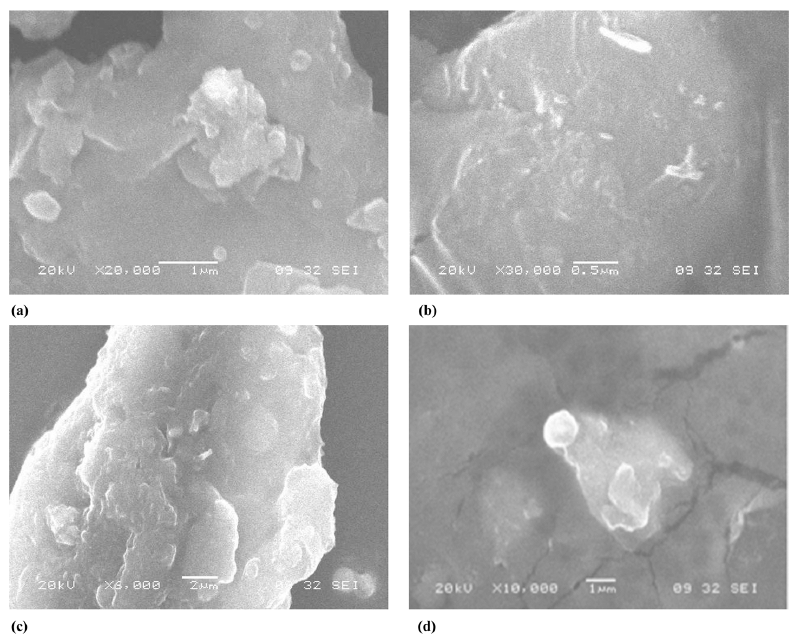
Figure 3. Scanning electron microscope (SEM) images of forest honey ( a ) and AgNPs synthesized using 20% ( b ), 40% ( c ), and 80% forest honey ( d ).